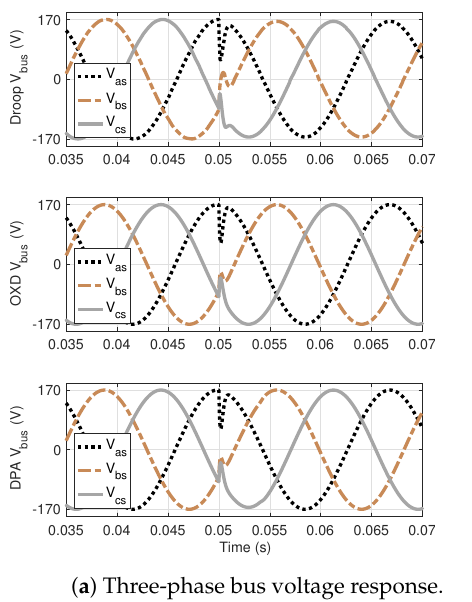
Figure 5. Scenario 1: ( a ) Three-phase bus voltage response to a bus load step change at t = 0.05 s for all V droop, OXD, and DPA. ( b ) Zoomed-in response to a bus load ω / Q three control methods: P − − step change at t = 0.05 s, to more easily identify performance